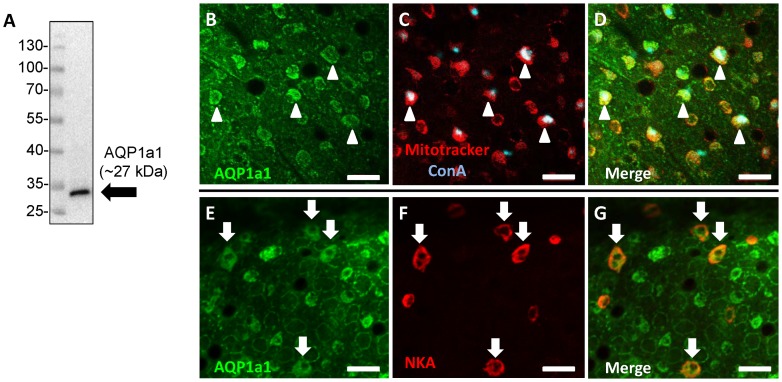
Aquaporin-1a1 is expressed in ionocytes on the skin of yolk sac in larval zebrafish.(A) A representative western blot showing that the eel aquaporin-1a1 (AQP1a1) antibody yielded a single immunoreactive band at ∼27 kDa in lysates of 4 dpf zebrafish larvae. (B) Fluorescent immunohistochemistry and confocal microscopy revealed that the expression of AQP1a1 on the skin of yolk sac (green), and a subset of cells stained positively with Mitotracker® (red) and concanavalin-A (conA; blue). (D) is the merged images of B and C. Cells labelled with arrowheads represent areas of colocalization of AQP1a1 and Mitotracker® or conA. (E) Some AQP1a1-positive cells (green) were also colocalized with (F) Na+/K+-ATPase staining (NKA; red). (G) is the merged images of E and F. Cells labelled with arrows represent areas of colocalization of AQP1a1 and NKA. Scale bar  = 25 μm.